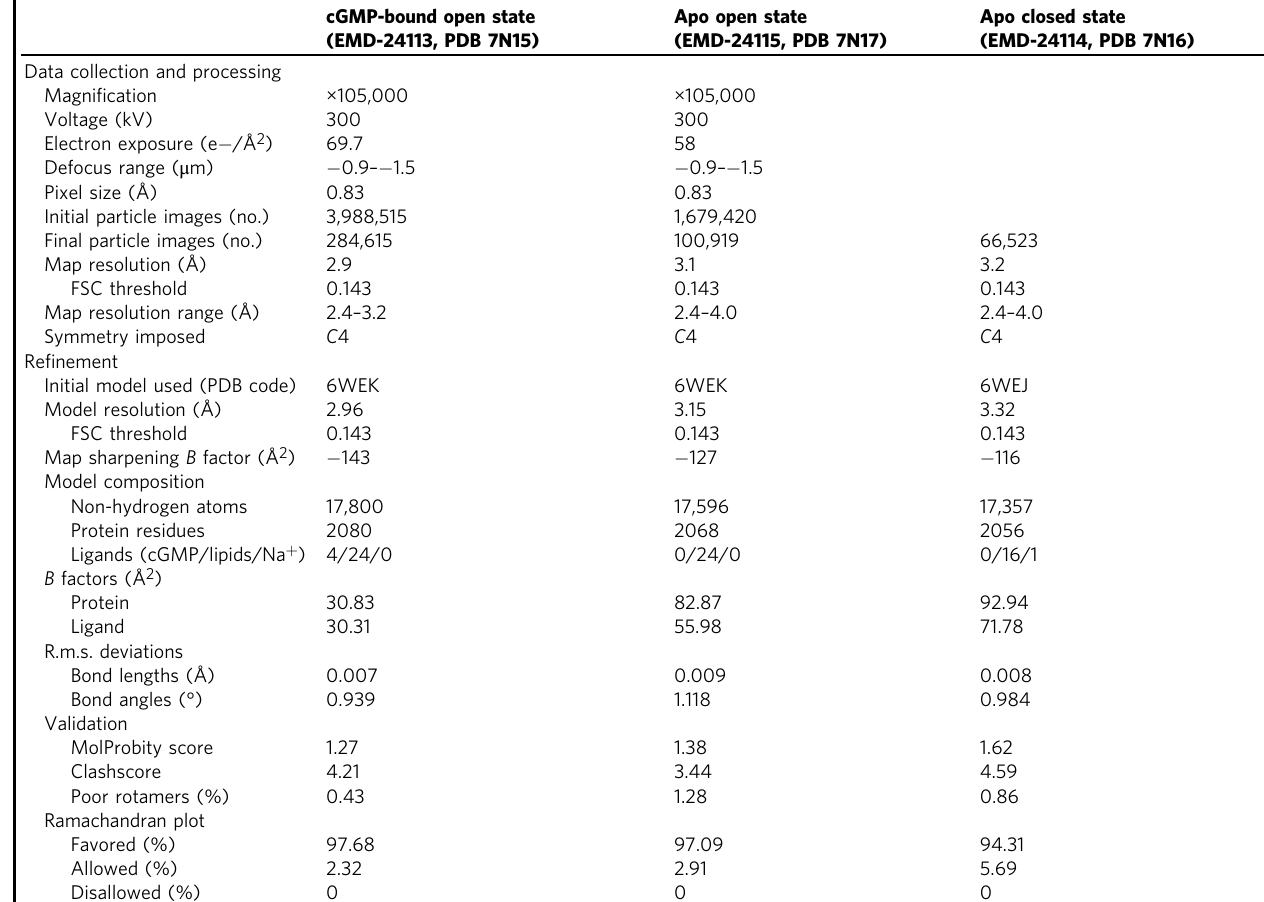
Table 1 Cryo-EM data collection, re fi nement and validation